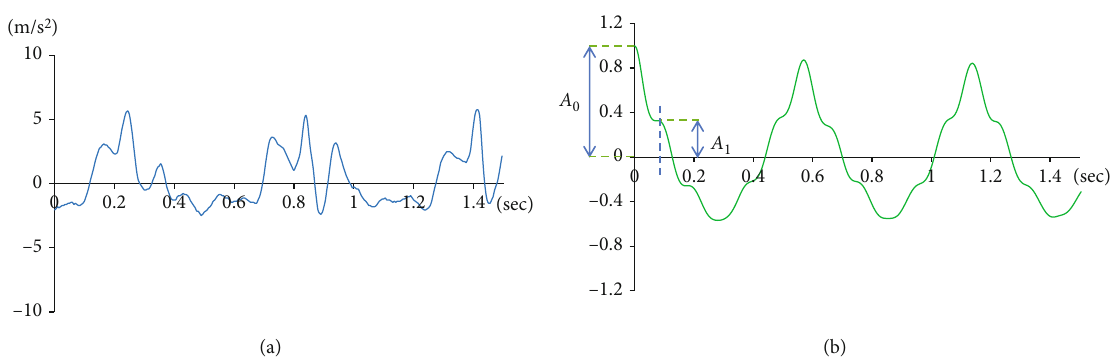
Figure 4: Trunk acceleration and auto correlation function. (a) Trunk acceleration waveform in the vertical direction. (b) Autocorrelation : the 0th amplitude peak; A : fi rst amplitude peak. function of trunk acceleration waveform. A 0 1 Table 1: GRF peak (% body weight) during walking. Table 2: Peak joint ranges of motion during